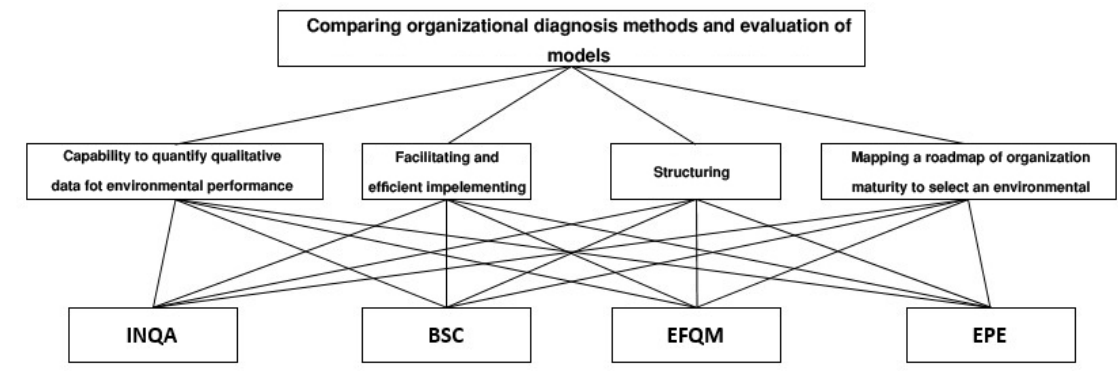
Figure 6. Research model based on hierarchical structure to prioritize research